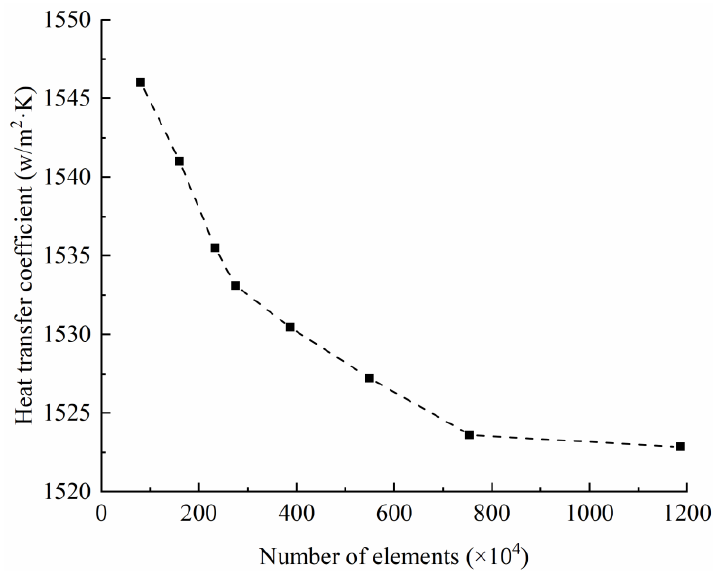
Figure 2. Grid system of the double-concentric pipe.